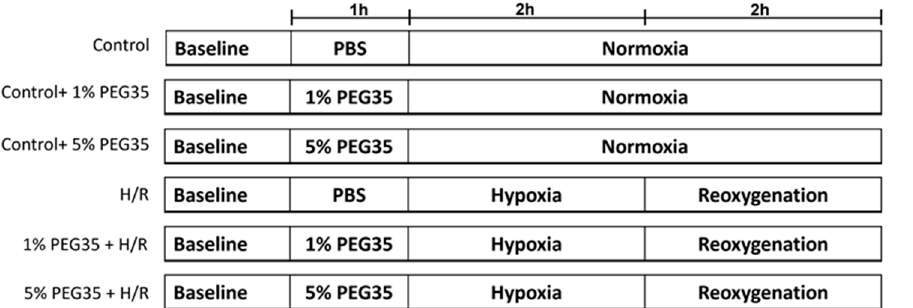
Figure 7. A schematic representation of the experimental protocol. HepG2 cells were randomly divided into the following groups: control, control treated with either 1% PEG35 (Ctl + 1% PEG35) or 5% PEG35 (Ctl + 5% PEG35), 2 h of hypoxia followed by 2 h of reoxygenation (H/R) and preconditioning with 1% PEG35 or 5% PEG35 prior to H/R, 1% PEG35 + H/R and 5% PEG35 + H/R, respectively.